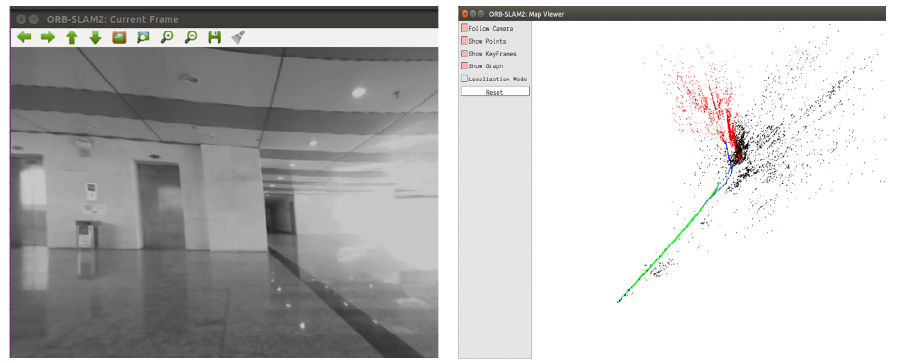
Figure 13. Localization results of ORB-SLAM2 in a low-texture environment.